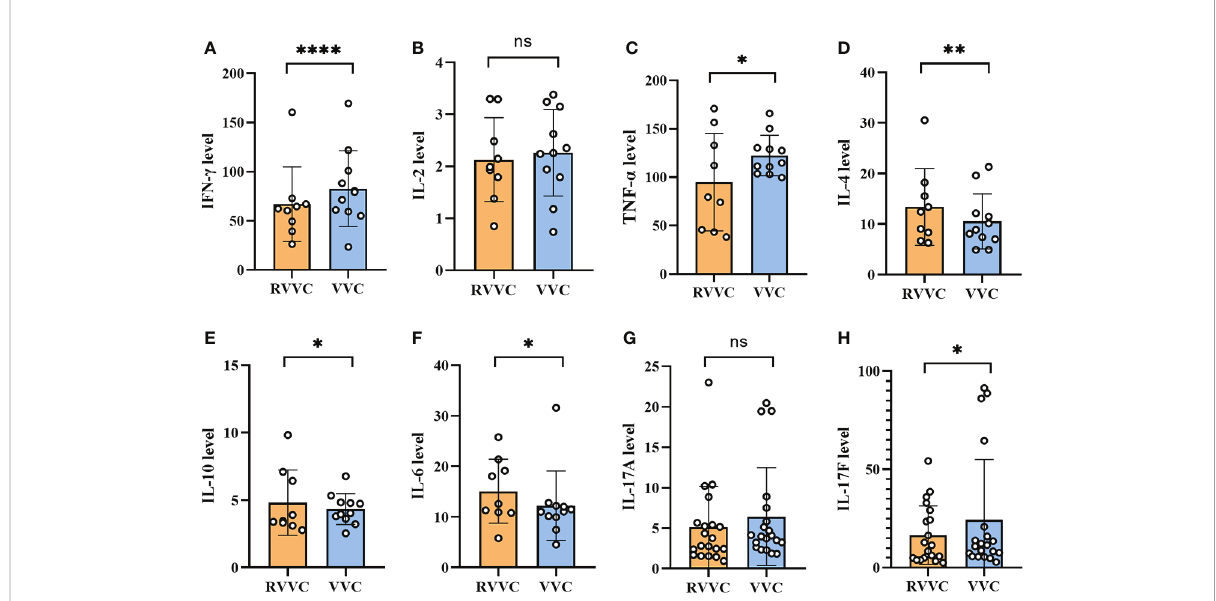
FIGURE 4 The serum was collected from the VVC and RVVC patients before the initiation of treatment to analyze the cytokines in the serum by LEGENDplex ™ . (A-C) represent the serum level of IFN- g , IL-2 and TNF- a (Th1 associated cytokines) of the patients with Recurrent vulvovaginal candidiasis (RVVC) and Vulvovaginal candidiasis (VVC), respectively. (D, E) represent the serum level of IL-4 and IL-10 (Th2 associated cytokines) of the patients with RVVC and VVC, respectively. (F-H) represent the serum level of IL-6, IL-17A and IL-17F (Th17 associated cytokines) of the patients with RVVC and VVC, respectively. Data are representative of three independent experiments. P value < 0.05 is regarded as a signi fi cant enrichment. Error bars represent SD, *p < 0.05, **p < 0.01, ***p < 0.001. ns, No signi fi